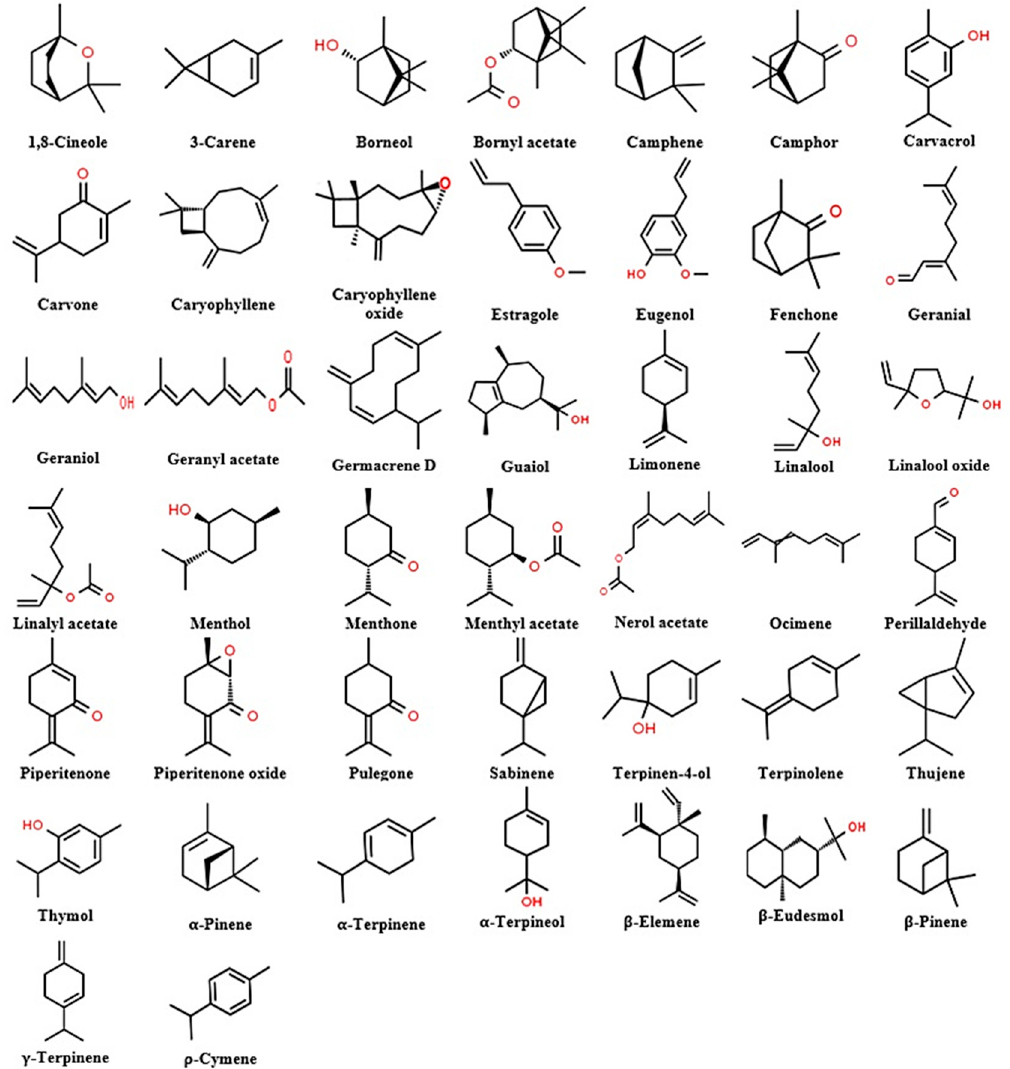
Figure 1. Chemical structure of main components identified in the essential oils of the Lamiaceae plant family.